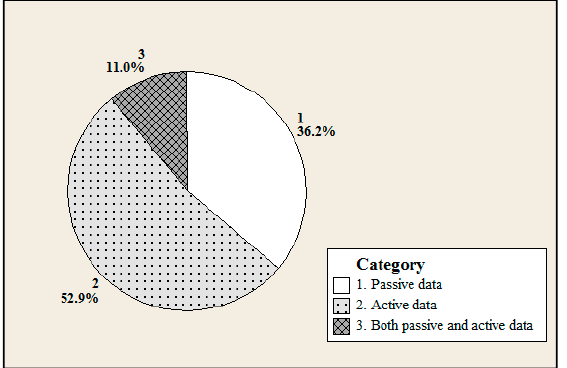
Figure 1. Summary of remotely sensed data used in individual tree crown detection and delineation (ITCD) and related literature from 1990–2015 ( N = 210). (ITCD) and related literature from 1990–2015 ( N =